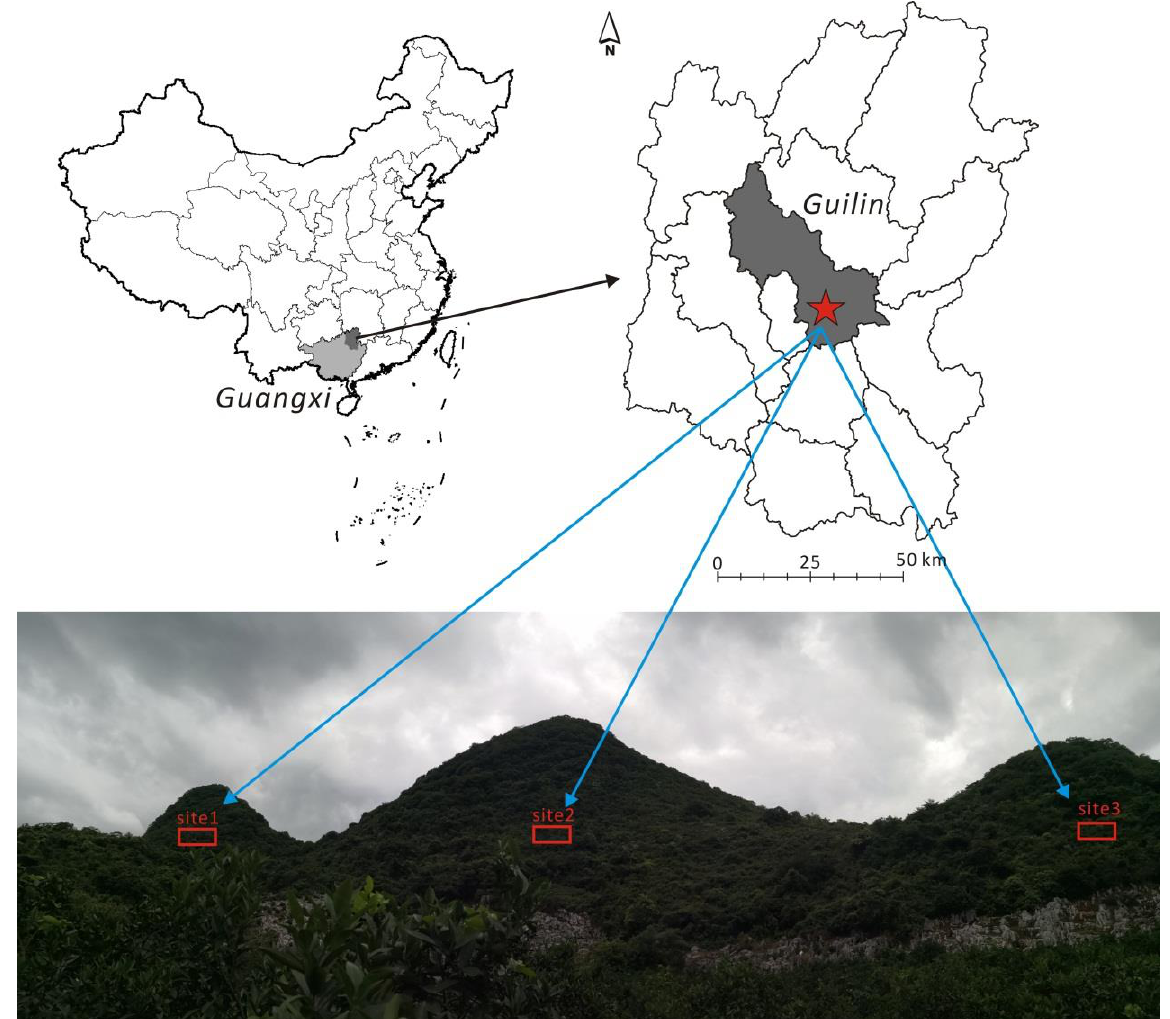
Figure 1. Location of sampling sites in Guilin county, Guangxi Zhuang Autonomous Region.